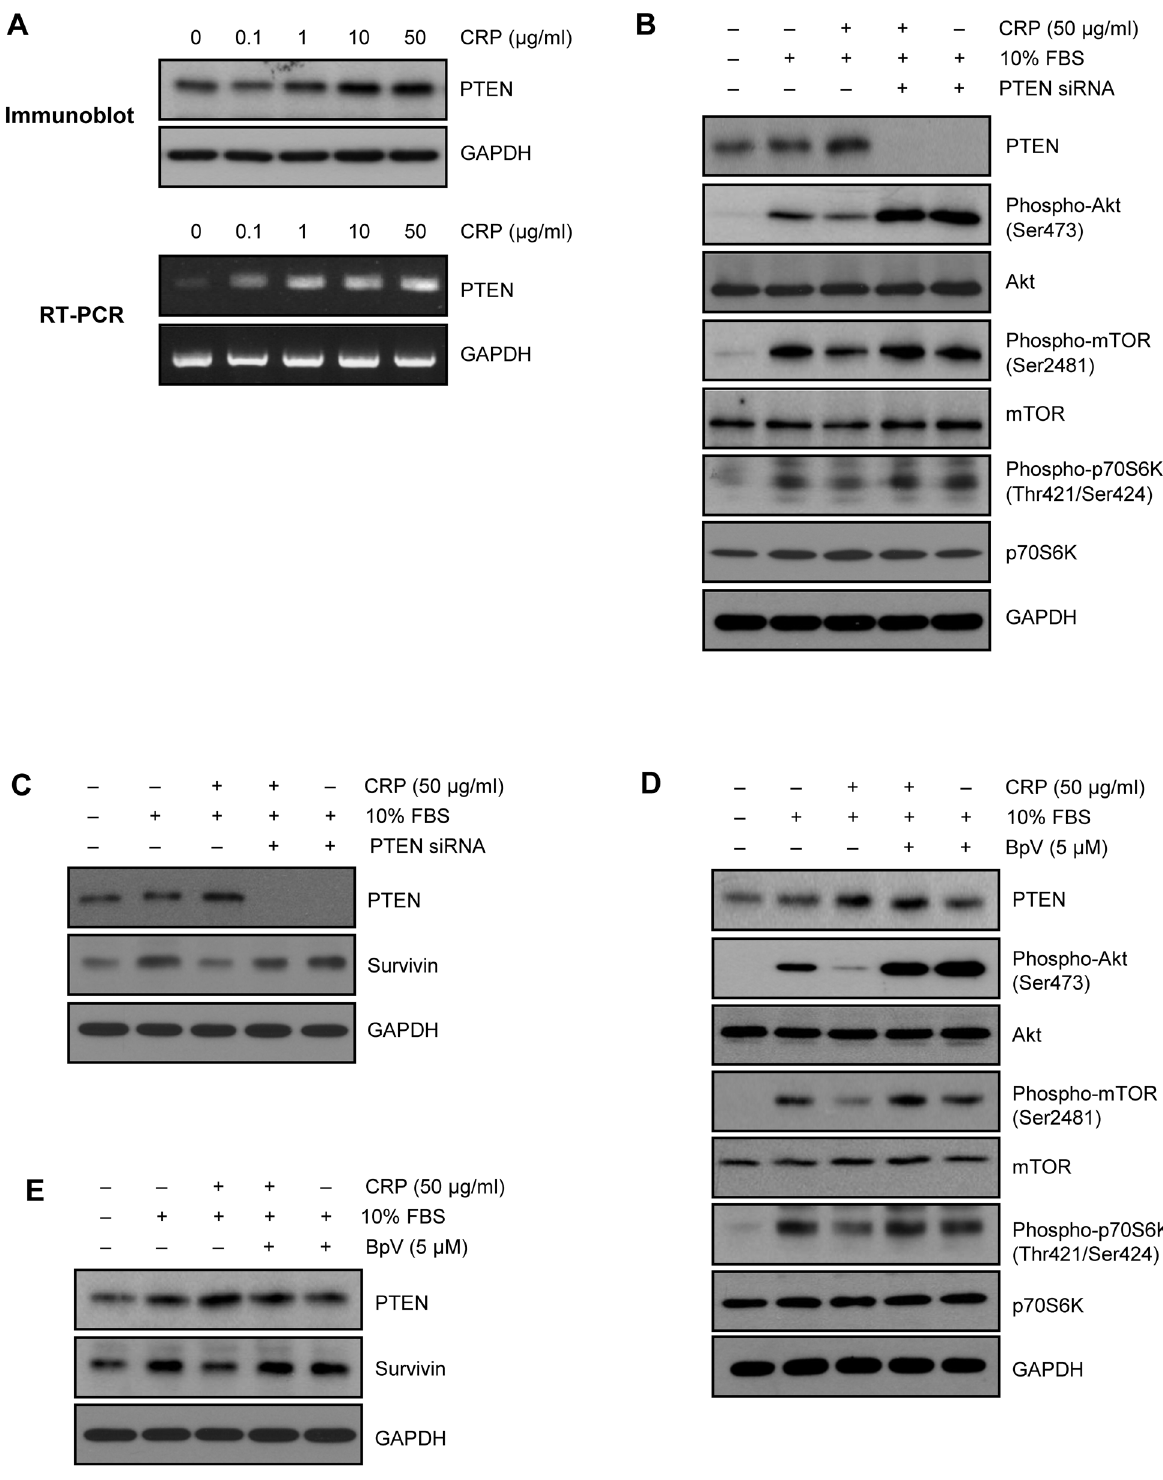
Figure 3. Role of PTEN in CRP-induced downregulation of Akt/mTOR/p70S6K pathway. (A) H9c2 cardiac myocytes were treated with indicated concentration of CRP in 0.5% FBS for 24 hours. Expression levels of PTEN were determined by immunoblot analysis and RT-PCR, respectively. (B) H9c2 cells transfected with 20 nM of PTEN siRNA were incubated 50 m g/ml of CRP in 0.5% FBS for 24 hours and then treated 10% FBS for 1 hour. Cells were harvested and analyzed for PTEN, Akt, mTOR and p70S6K signaling pathway by immunoblot assay. (C) PTEN siRNA-transfected cells were incubated 50 m g/ml of CRP in 0.5% FBS for 24 hours and then treated 10% FBS for 24 hours. Protein levels of PTEN or survivin were analyzed by immunoblot assay. (D) H9c2 cells pretreated with PTEN inhibitor (BpV, 5 m M) for 1 hour were incubated with 50 m g/ml of CRP in 0.5% FBS for 24 hours and then treated 10% FBS for 1 hour. Cells were harvested and analyzed for PTEN, Akt, mTOR and p70S6K signaling pathway by immunoblot assay. (E) PTEN inhibitor-pretreated cells were incubated 50 m g/ml of CRP in 0.5% FBS for 24 hours and then treated 10% FBS for 24 hours. Protein levels of PTEN or survivin were analyzed by immunoblot assay. doi:10.1371/journal.pone.0098113.g003 PLOS ONE |